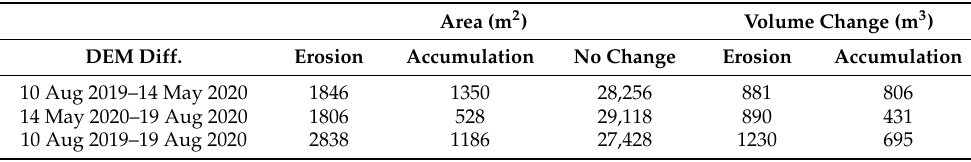
Table 2. Calculated changes between subsequent DEMs. Area (m 2 ) Volume Change (m 3 ) DEM Diff. Erosion Accumulation No Change